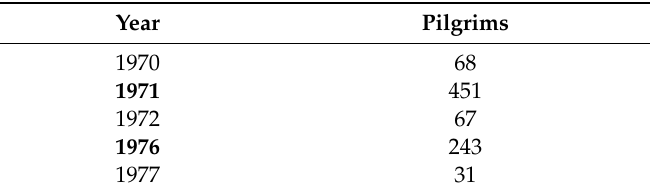
Table 1. Pilgrims registered at the Pilgrim’s Reception O ffi ce (1970–1977). (Holy Years are in bold) Source: Oficina del Peregrino (Pilgrim’s Reception O ffi